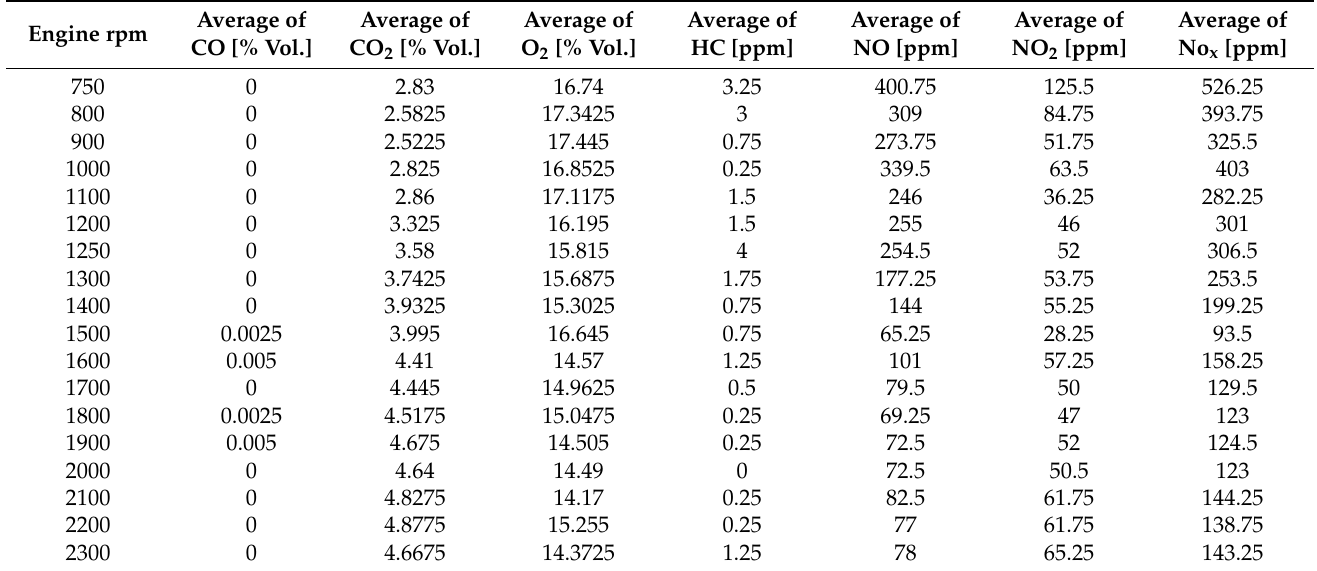
Table 3. Average exhaust gas values of the unloaded